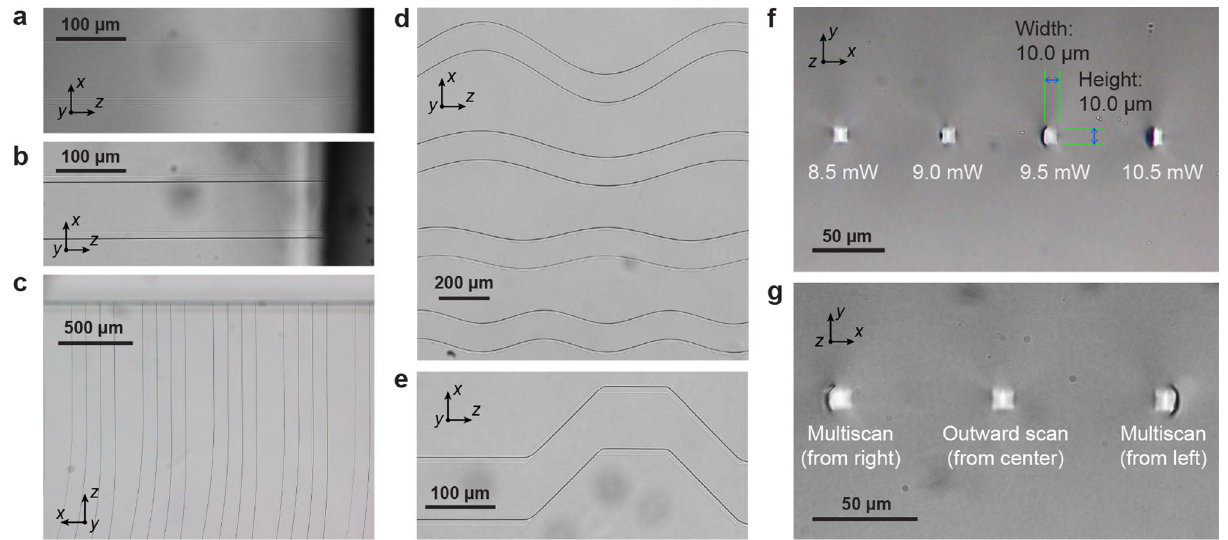
Figure 4. Bright field microscopy of fabricated waveguides and integrated cracks. ( a ) Top-down images of waveguides before polishing and ( b ) after polishing, with cleaved microcrack visible on lower edge. ( c ) Waveguide bend arrays. ( d ) Examples of cracks fabricated along sinusoidal and ( e ) stepped 45 ( f ) Cross sections of waveguides inscribed at writing powers P w from 8.5 to 10.5 mW ( ± 0.05 mW), and ( g ) using different multiscan line orders, for P w = 9.5 mW. All waveguides written with width 10 μm, pulse density D = 3 × 10 5 pulses/mm, scanline spacing s = 200 nm, (cid:31) w = 515 nm, 0.4 NA objective lens, and circular